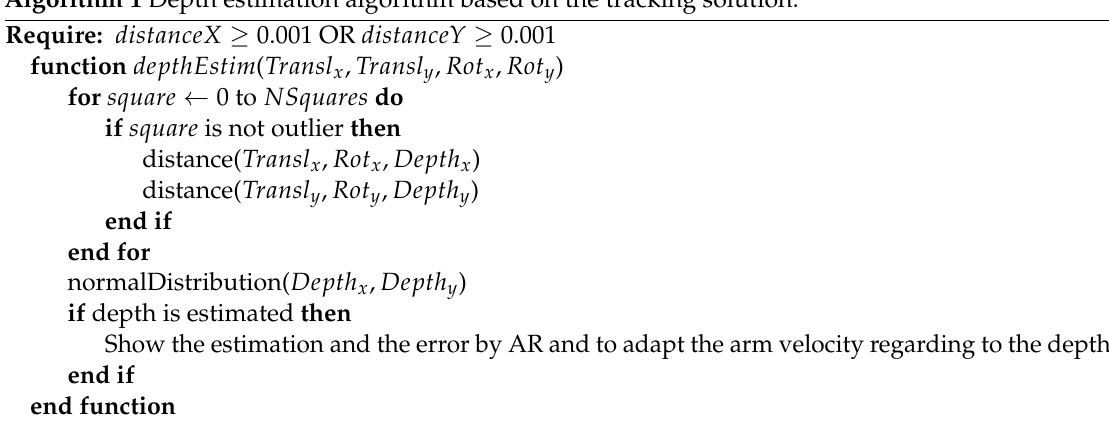
Algorithm 1 Depth estimation algorithm based on the tracking